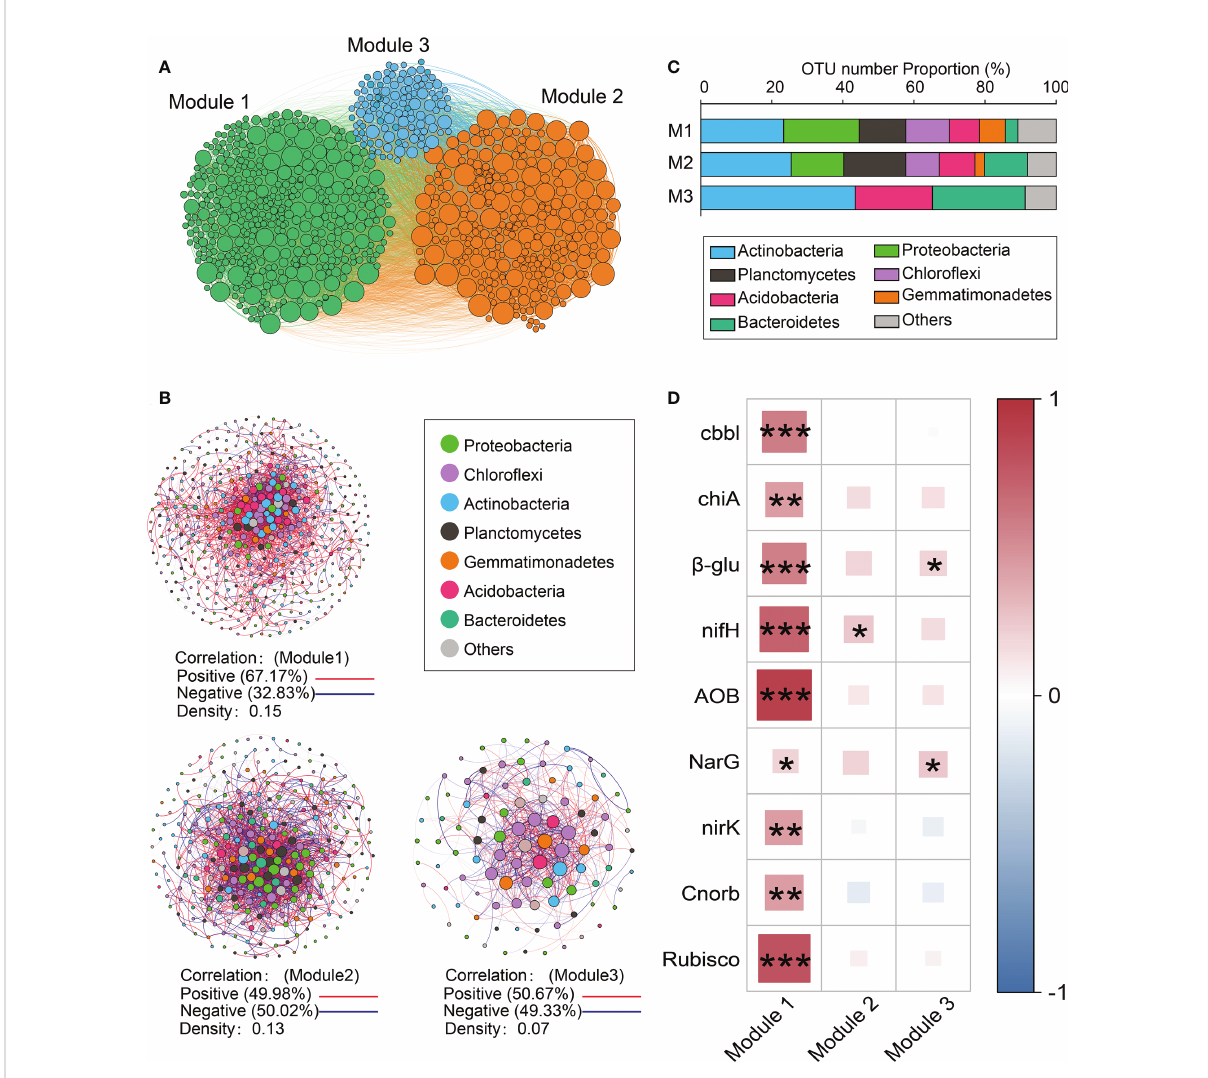
FIGURE 3 Modules based on networks. (A) A Network diagram with nodes colored according to each of the three main modules (Modules #1 – 3); (B) Operational taxonomic unit (OTU) number properties of the dominant taxa in the main modules; (C) Dominant taxa (relative abundance >0.05) from Modules #1 – 3, respectively. A connection stands for a strong (Spearman ’ s r > 0.8) and signi fi cant ( P <0.001) correlation. The co-occurrence network is colored by phylum. The size of each node is proportional to the relative abundance of each taxa. A red edge indicates a positive correlation between two individual nodes, while a blue edge indicates a negative correlation; (D) Spearman correlations between the abundance of functional genes and the relative abundance of dominant taxa from Modules #1 – 3 (z-score). * P < 0.05, ** P < 0.01, *** P <